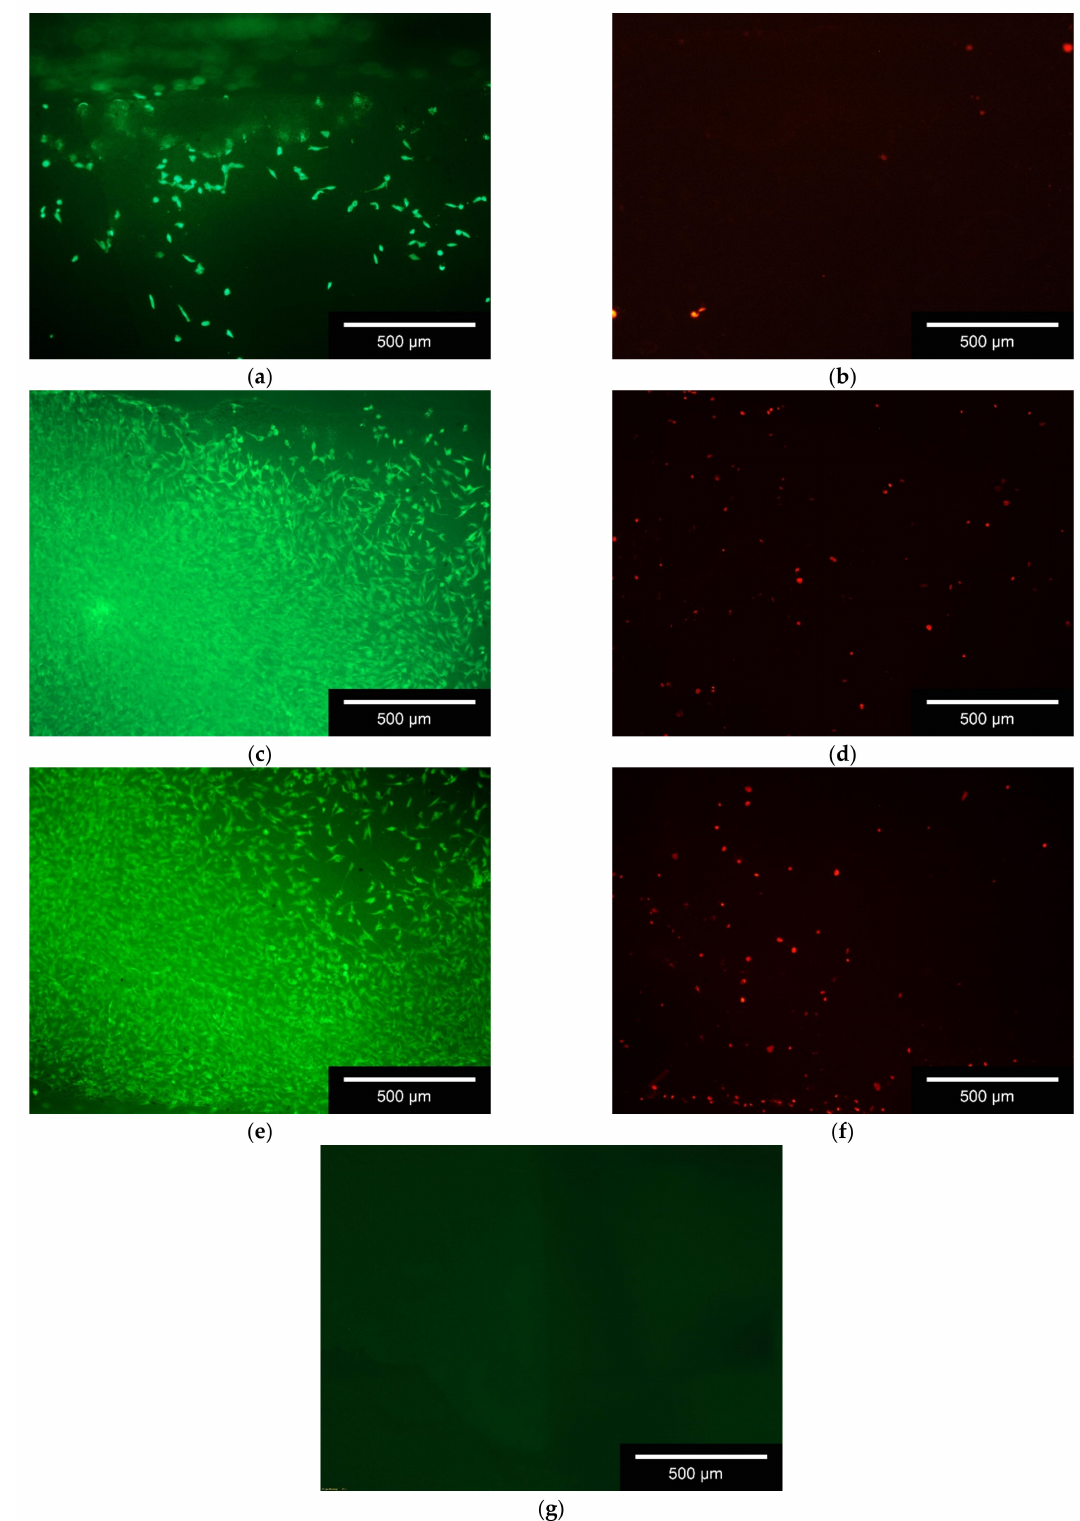
Figure 8. Live/Dead Staining; exemplary images of 1000(2500); ( a ) living cells on the scaffold after 3 days; ( b ) dead cells on the scaffold after 3 days; ( c ) living cells on the scaffold after 7 days; ( d ) dead cells on the scaffold after 7 days; ( e ) living cells on the scaffold after 10 days; ( f ) dead cells on the scaffold after 10 days; ( g ) auto-fluorescence of the ceramics, exposure time 10 × as high as the other; living cells = green; dead cells = red; white bar = 500 µ m, images taken with Olympus BX-53 Fluorescence